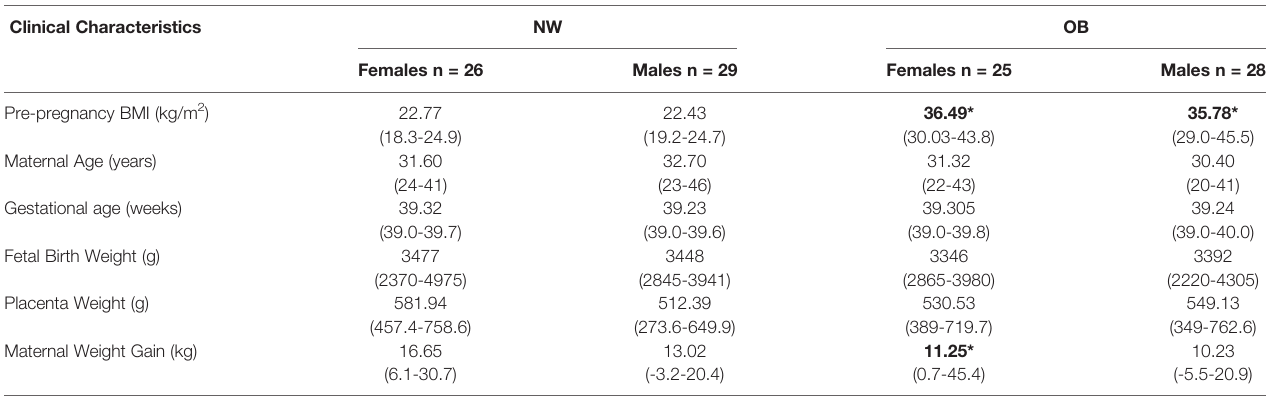
TABLE 1 | Clinical characteristics of study patients. Clinical Characteristics